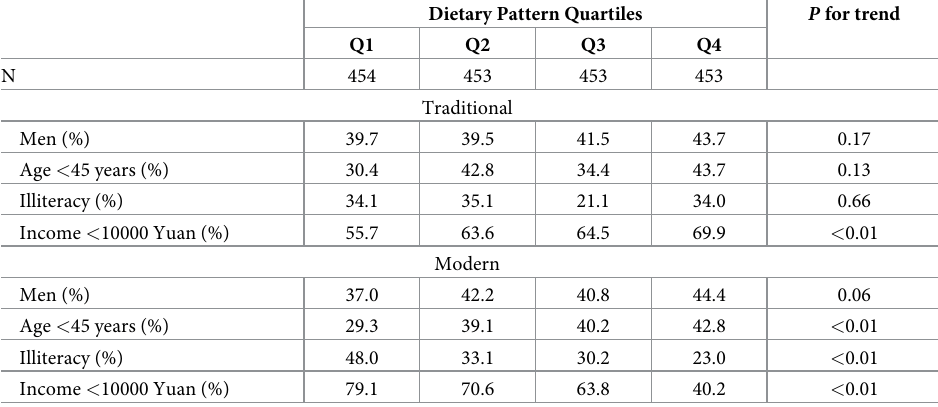
Table 3. Sociodemographic characteristics of the participants across quartiles of the dietary patterns.